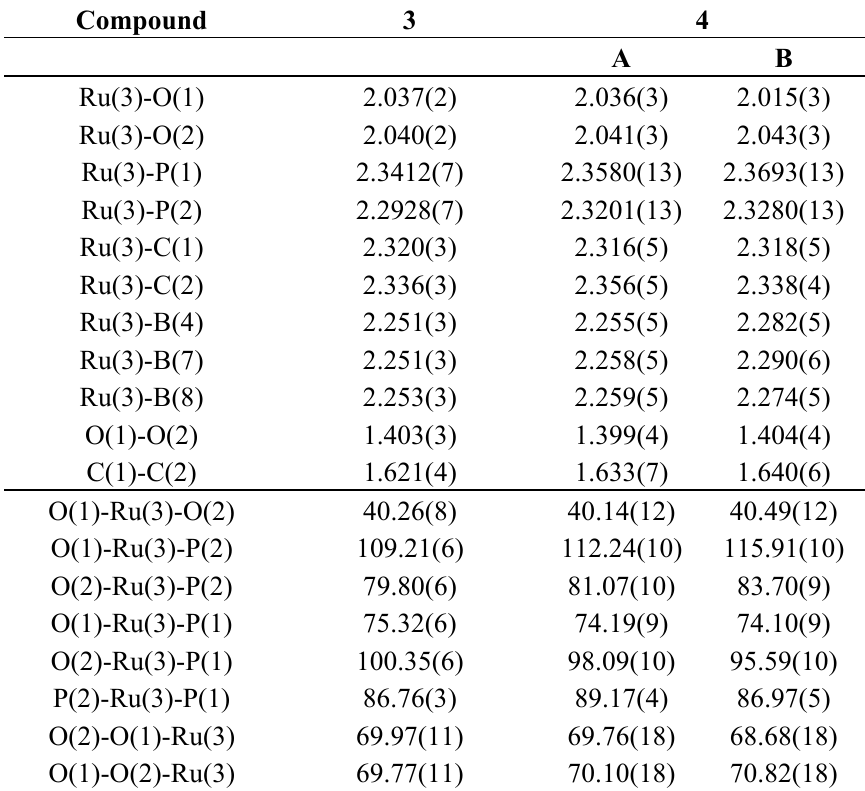
Table 1. Selected bond lengths (Å) and angles (deg.) in 3 and 4 (two independent molecules A and